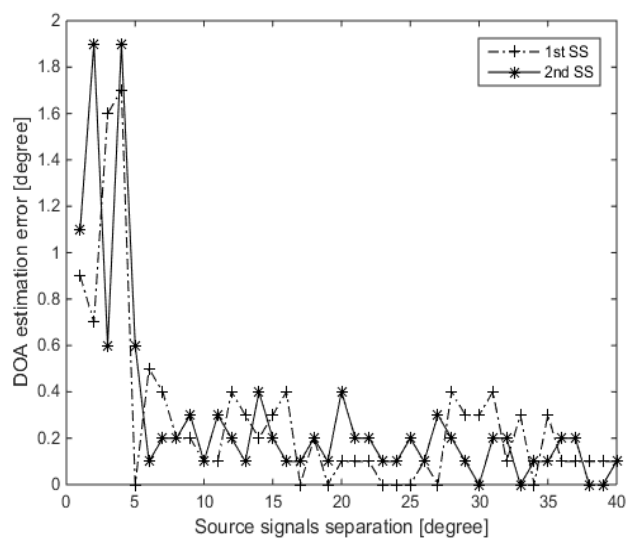
Figure 19. DOA estimation error for two sources as a function of separation between the two sources, SNR = 10 dB, 10 snapshots and one iteration of MVDR